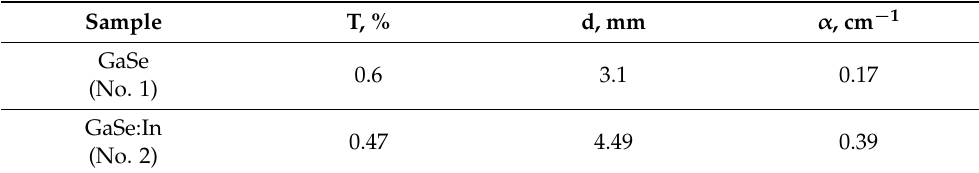
Table 1. Absorption coefficient of the samples at a wavelength of the Ho3+:YAG laser—2.091 µ m.